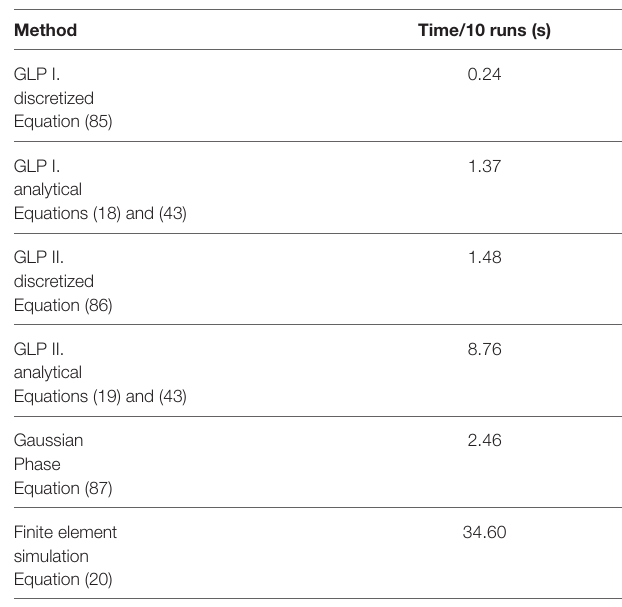
TABLE 1 | Computation time for 10 calculation runs for the total magnetization of the different calculation